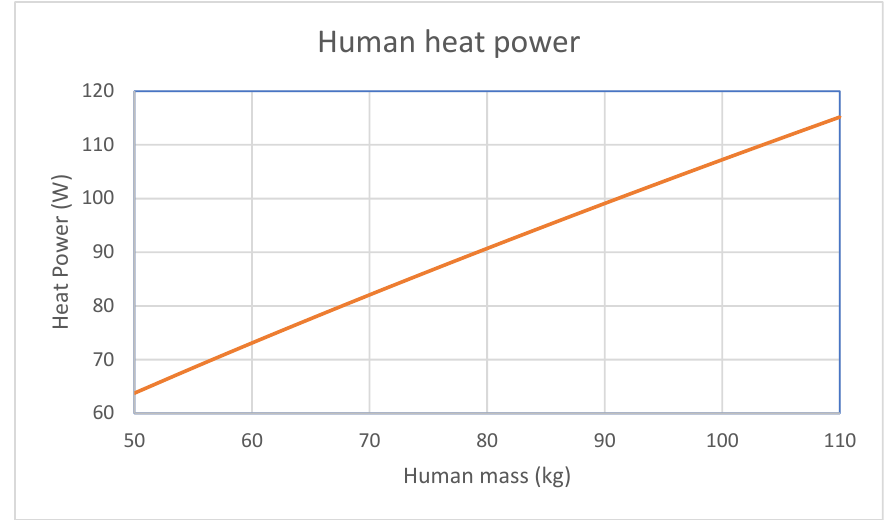
Figure 1. Average heat power (W) given off by a human as a function of mass.